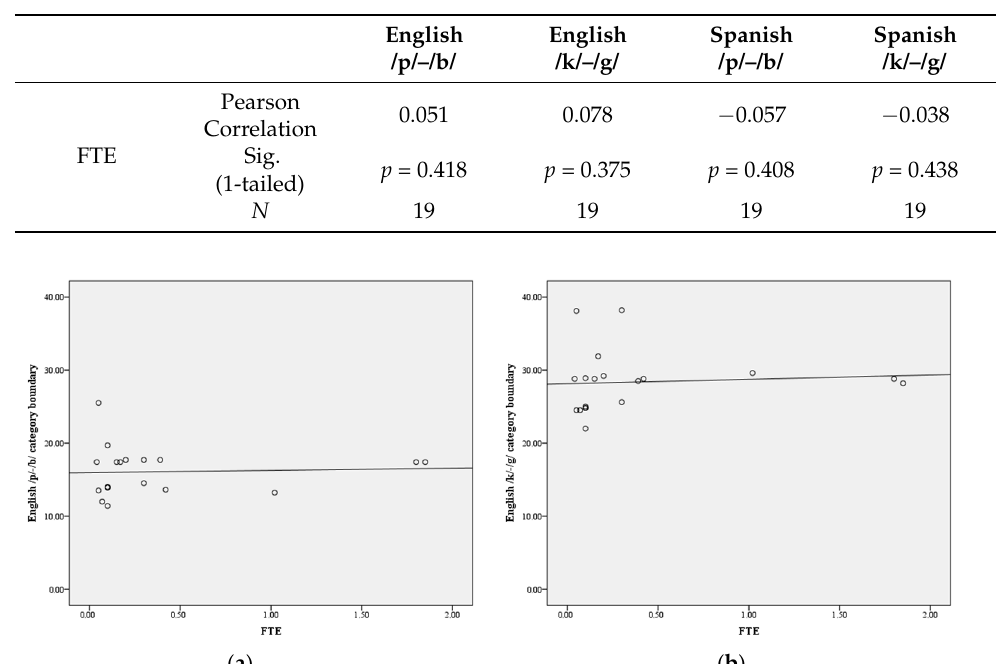
( b ) Figure 2. Scatterplots with fit lines for FTE ( x axis) and category boundary ( y axis) in Spanish by the English learners of Spanish. ( a ) Category boundary for the /p/–/b/ contrast in Spanish. ( b ) Category boundary for the /k/–/g/ contrast in Spanish. Furthermore, the degree to which L2 use, LOR and L2 instruction (independent var- iables) predicted category boundary location (dependent variable) was assessed by means of a series of multiple regression analyses—i.e., one per contrast. The statistical analyses revealed that these variables did not significantly predict category boundary placement for the English contrasts or Spanish /p/–/b/ (English /p/–/b/: F (3, 15) = 0.199, p = 0.896, R 2 = 0.038; English /k/–/g/: F (3, 15) = 0.569, p = 0.644, R 2 = 0.102; Spanish /p/–/b/: F (3, 15) = 0.193, p = 0.900, R 2 = 0.037). As revealed by the R 2 values, this set of variables only accounted for 3.8% (in the case of the L1 bilabial contrast), 10.2% (for L1 velars) and 3.7% (for L2 bilabi- als). In the case of Spanish /k/–/g/, the analysis revealed a significant result ( F (3, 15) = 4.148, p = 0.025, R 2 = 0.453). Specifically, in this case, only L2 instruction was found to add statis- tical significance to the prediction ( p = 0.00). Note that, in spite of the significant result, the independent variables only accounted for 45.3% of variability. 3.2. Interim Discussion The L1 and L2 perception of bilabial and velar stops by English learners of Spanish was analyzed by means of a forced-choice categorization test for each place of articulation involving stimuli from a VOT continuum. The values of the category boundaries obtained by the English learners of Spanish were considerably late (16.1 for English /p/–/b/; 28.4 for English /k/–/g/; 15.7 for Spanish /p/–/b/ and 26.7 for Spanish /k/–/g/), which suggests that